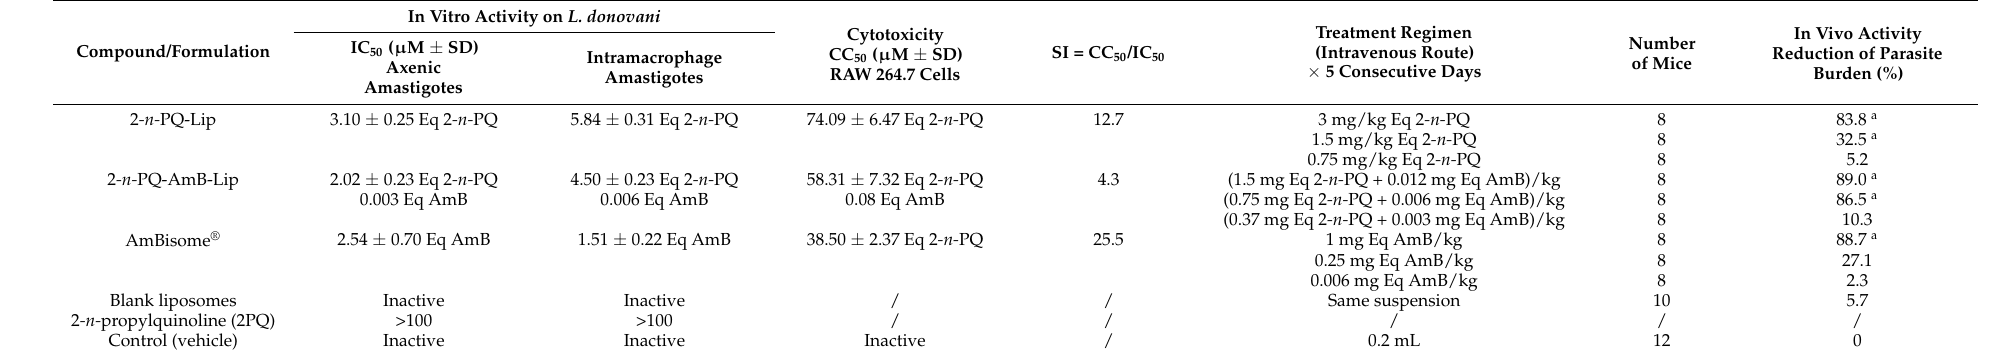
Table 2. In vitro and in vivo antileishmanial activity of liposomal formulations of 2 -n- propyl quinoline and amphotericin